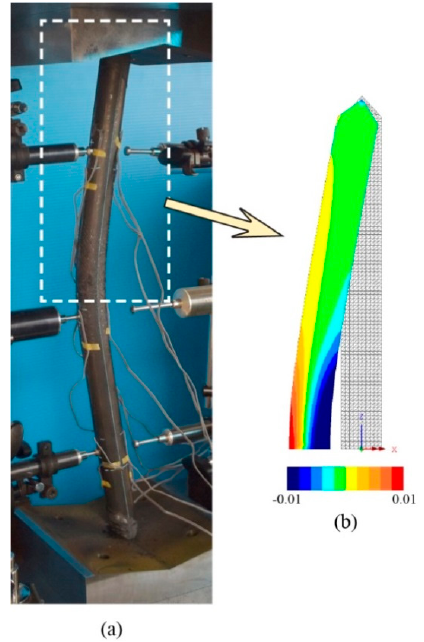
Figure 8. Failure mode of control unstrengthened specimen: ( a ) NS56BL and ( b ) NS56BL-FE along with longitudinal ( z ) strain contour.